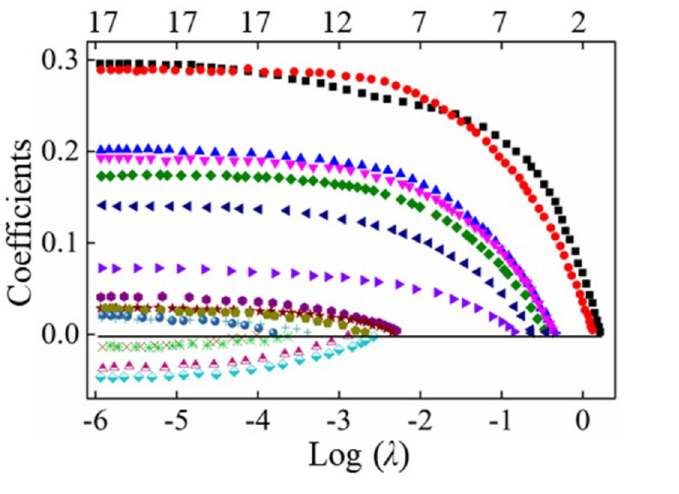
Fig 5. Coefficient solution path.